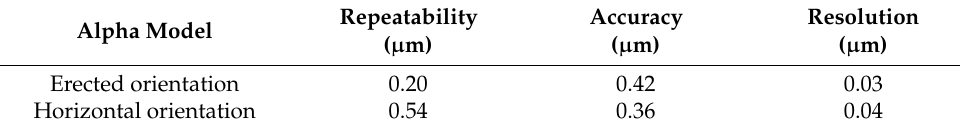
Figure 34. Results of calibrations of the LCMDS Alpha Model operating in two different orientaitons. Table 3. Parameters of performance of the LCMDS Alpha Model.